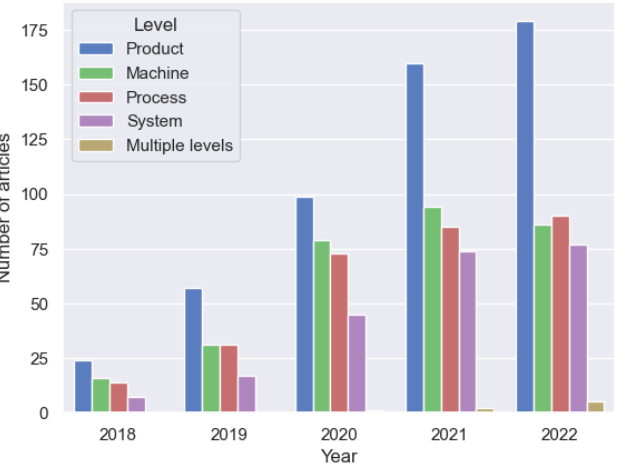
Figure 3. Trends in ML publications in manufacturing in the past five years by Four-Level grouping.